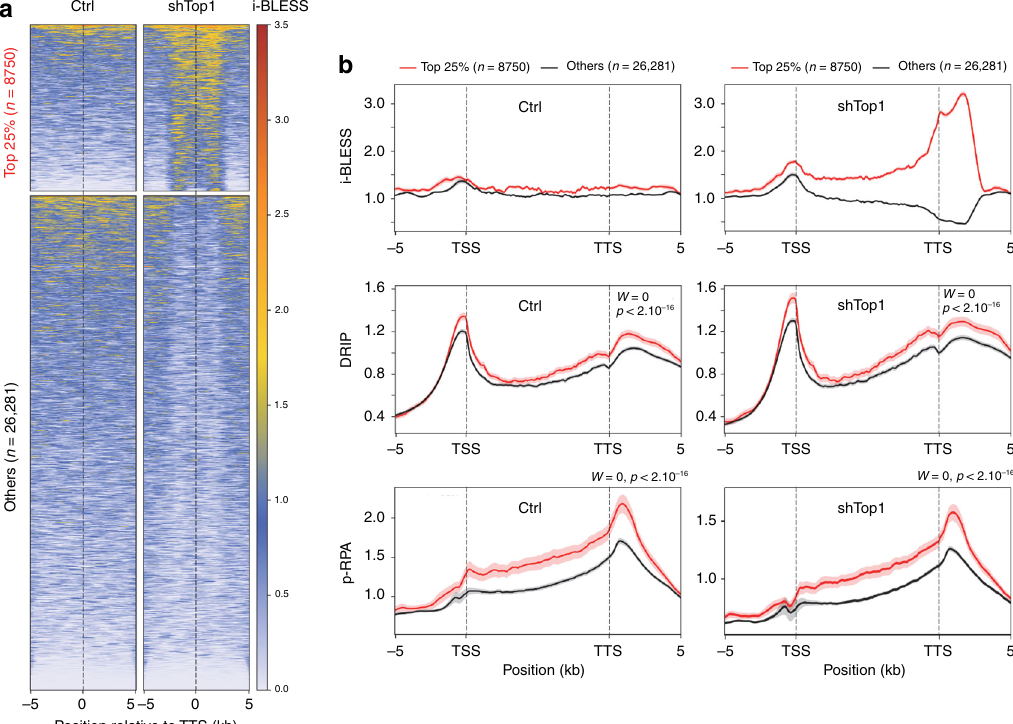
Fig. 5 DSBs form at TTS of genes enriched in R-loops and p-RPA in shTop1 cells. a Heat map of the intensity of i-BLESS signal at TTS in control and shTop1 cells for two groups of genes determined according to the intensity of i-BLESS signal at the TTS (±2 kb) in shTop1 cells (Top 25%). b Metaplots of i- BLESS, RNA:DNA hybrids and p-RPA32 S33 signal for the Top 25% (red) and other (black) genes in control and shTop1 HeLa cells. Error bars indicate SEM. Differences in signal intensity at TTS ±2 kb were calculated with the Wilcoxon rank-sum test with continuity